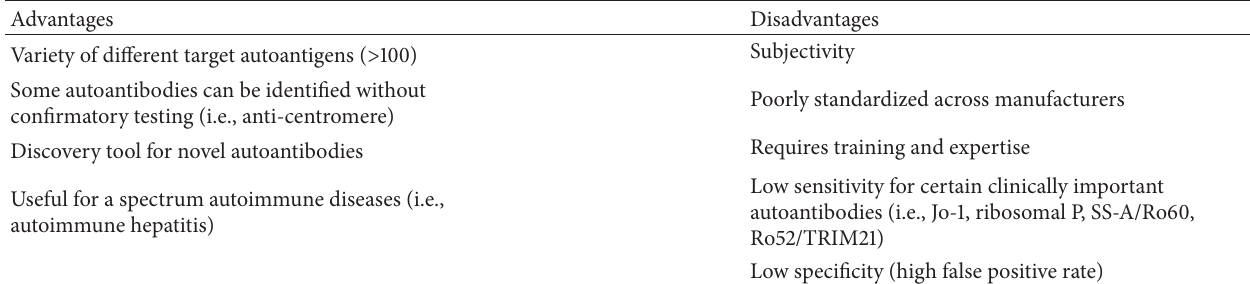
Table 5: Advantages and disadvantages of the HEp-2 ANA test.